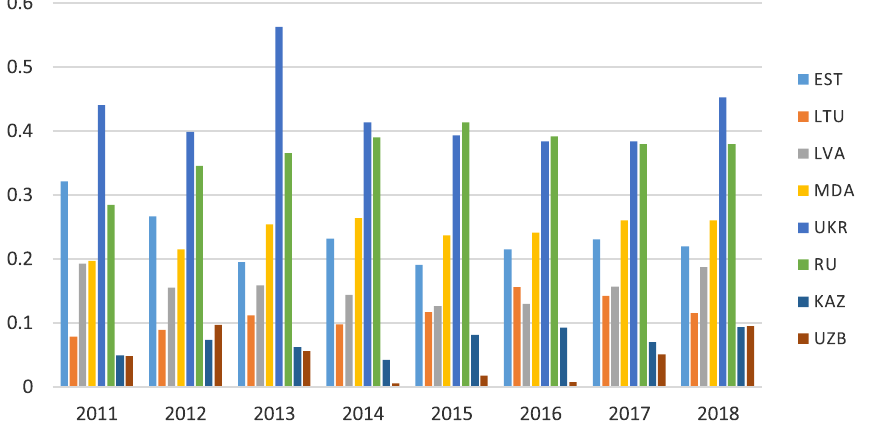
Figure 5. Charges for the use of intellectual property, payments (% of GDP) in post-Soviet countries in 2011–2018.